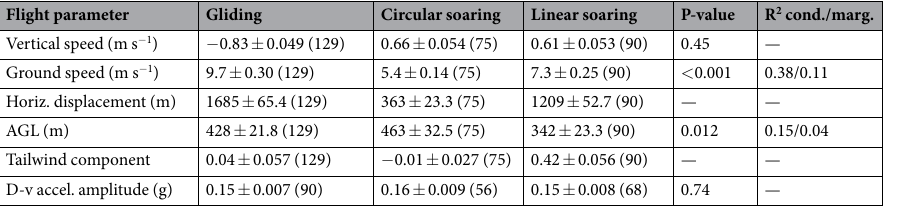
Table 2. Summary of parameters of the different flight modes. Parameters are summarized as mean ± standard error (sample size). P-values compare only the two soaring modes, and result from GLMM models where the flight parameter is the response variable, the soaring model is the fixed factor and bird identity and the day of data collection are the random factors. Conditional and marginal R 2 were calculated following Nakagawa and Schielzeth 66